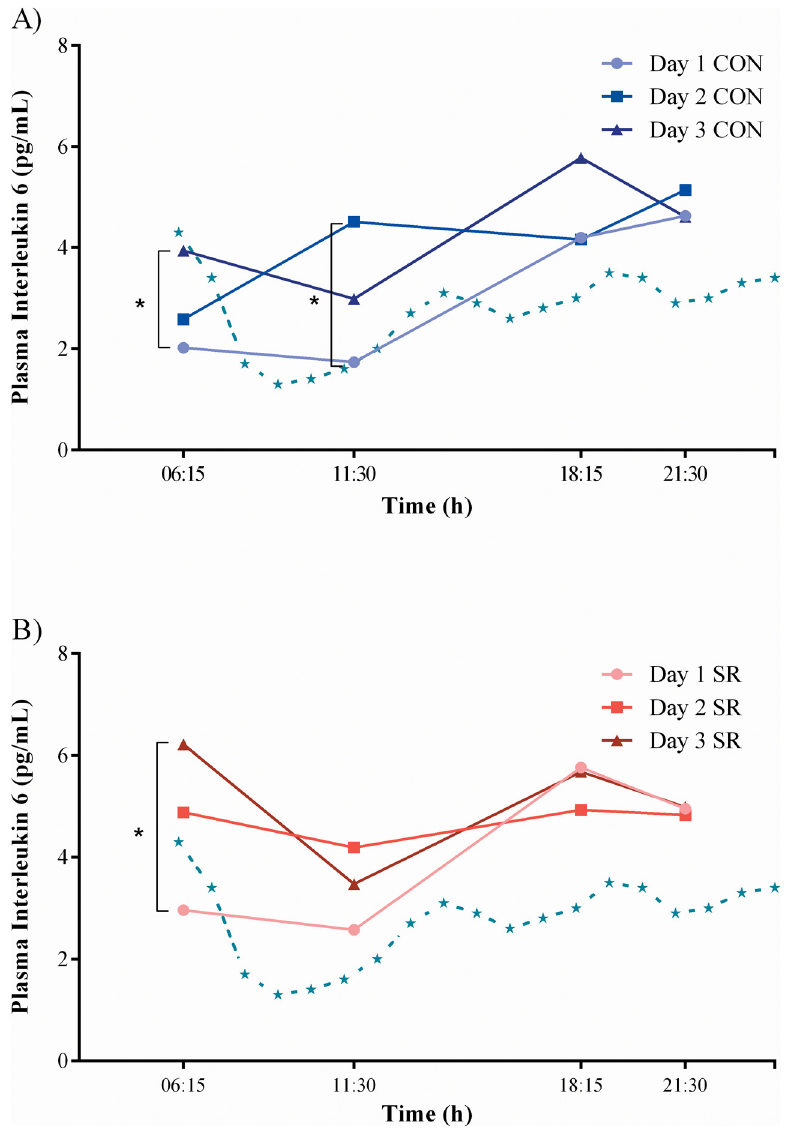
Fig 4. Predicted REML means for IL-6 profile across days in CON (A) and SR (B) conditions. Data was log-transformed prior to analysis. For ease of interpretation, values were back transformed to pg/mL and average standard error of difference = 1.29. NB: no shortened sleep prior to day 1. Dashed lines represent IL- 6 levels for healthy young adults under control conditions (i.e, 8-h sleep opportunity) [47]. Significant differences between days within the same condition and time of day are indicated by * ( p <